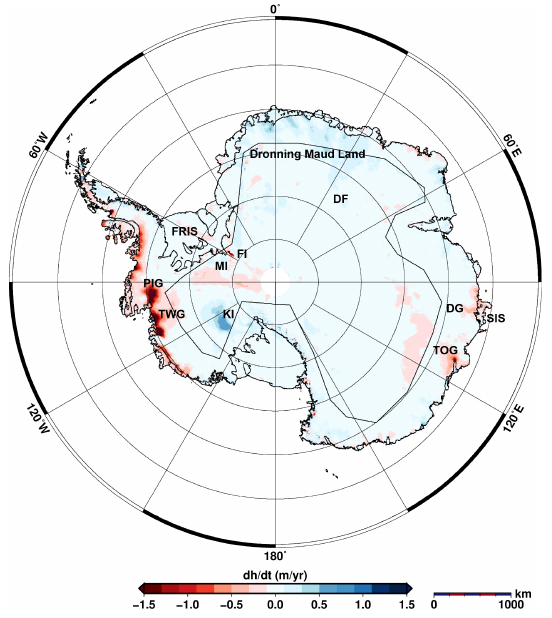
Figure 10. Map of elevation change of Antarctica between Jan- uary 2011 and January 2014 derived from along-track process- ing of three full CryoSat-2 cycles. The black polygon indicates the mode mask of CryoSat-2. Inside the polygon LRM and out- side SARIn data were acquired. DF: Dome Fuji, PIG: Pine Is-